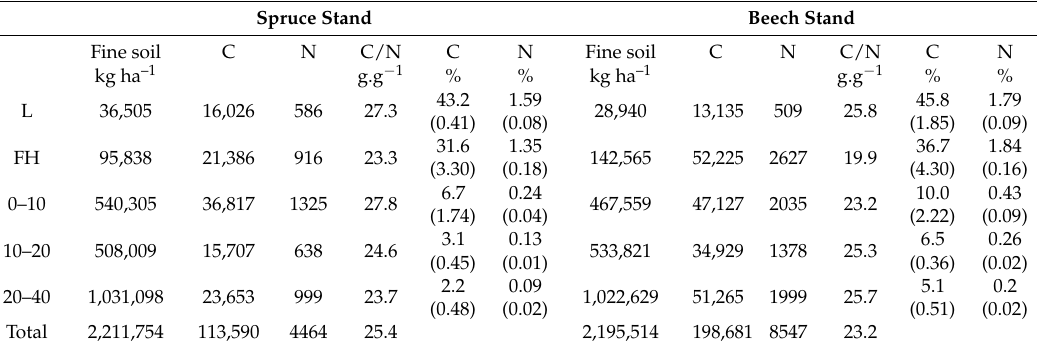
Table 3. Pools (kg · ha − 1 ) of fine soil (LFH < 5 mm; 0–40 cm < 2 mm), carbon, and nitrogen and the mass ratio of C:N in spruce and beech soils. Total C and N concentration in soil profiles of spruce and beech forests; standard deviations in parentheses and significant differences ( p < 0.05) among stands are highlighted in